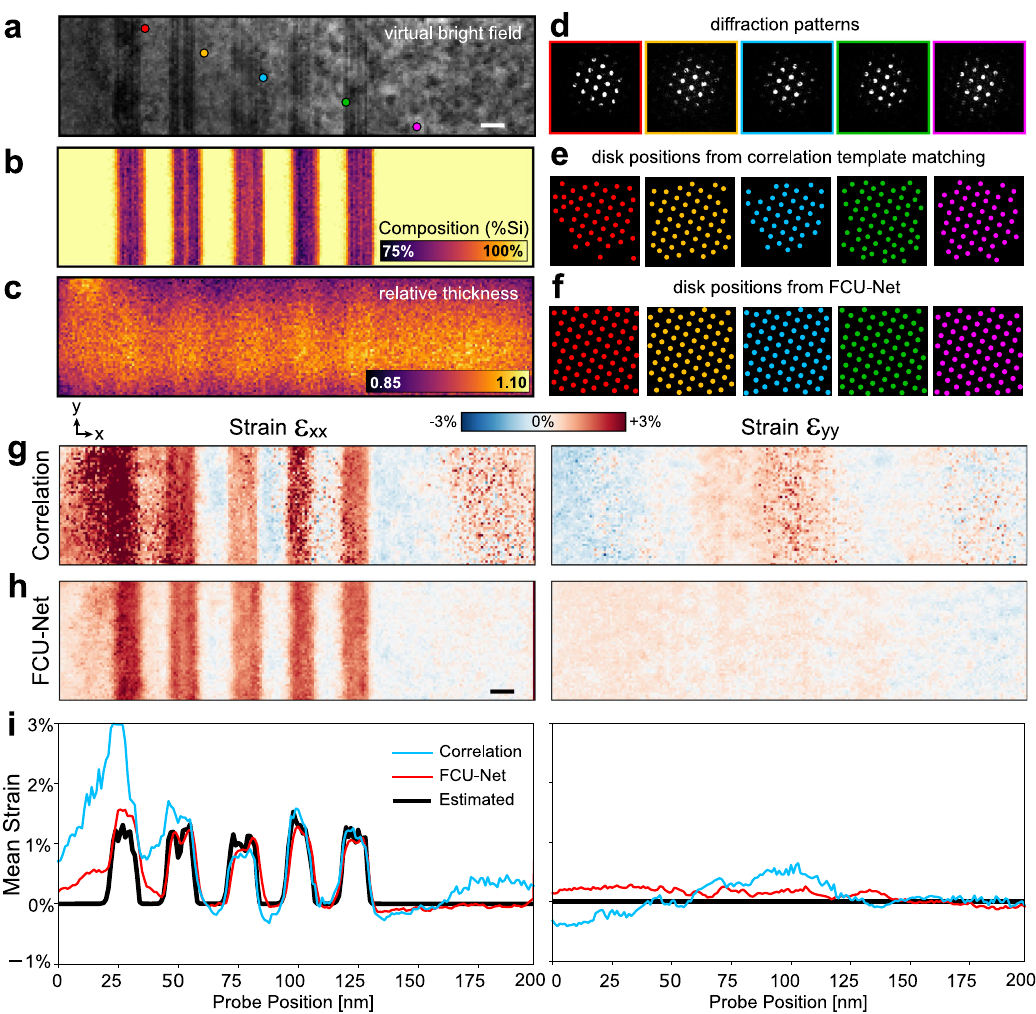
Fig. 6 Experimental strain and composition characterization of a Si-Si 0.87 Ge 0.13 multilayer stack. a Virtual bright fi eld calculated from center disk. b Composition and c relative thickness, estimated from STEM-EELS. d Diffraction patterns corresponding to the probe positions marked in (a), with estimated Bragg disk positions from e correlation template matching and f FCU-Net. g Strain maps measured from correlation template matching. h Strain maps measured from FCU-Net. i Mean strain values parallel to the multilayer normal direction, for correlation, FCU-Net, and estimated from the STEM-EELS composition. Scale bars are equal to 10